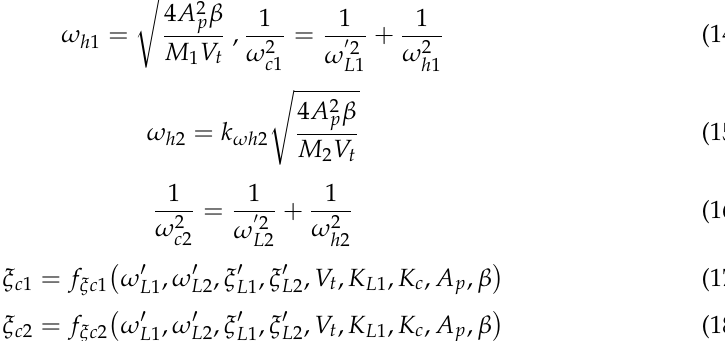
Figure 9. The condensed control block diagram of the actuator-engine system. In Figure 9, the composite hydro-mechanical resonance frequencies ( ω c 1 , ω c 2 ) are cou- pled from the structural resonant frequencies ( 𝜔 (cid:3013)(cid:2869)(cid:4593) , 𝜔 (cid:3013)(cid:2870)(cid:4593) ) and hydraulic resonant frequen- cies ( ω h 1 , ω h 2 ). Analogous to the one-mass-one-spring model [2,3,27], the first set of hy- draulic and composite frequencies ( ω h 1 , ω c 1 ) can be given in Equation (14), similar forms of the second set of frequencies ( ω h 2 , ω c 2 ) are proposed in Equations (15) and (16), where k ω h2 is a correction factor, and the damping ratios ( ξ c 1 , ξ c 2 ) have to be presented as ( f ξ c 1 , f ξ c 2 ) roughly, since a direct derivation is impossible. In fact, their precise algebraic representa- tions are not cared much since they can be identified from experiment as shown later.